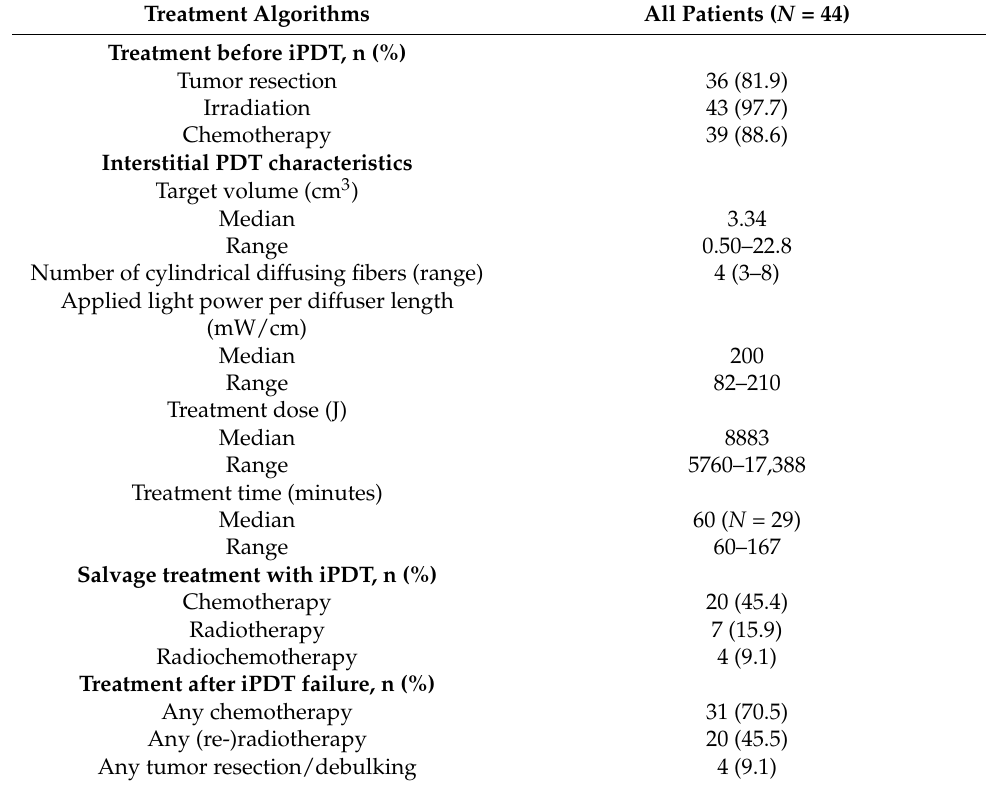
Table 2. Treatment